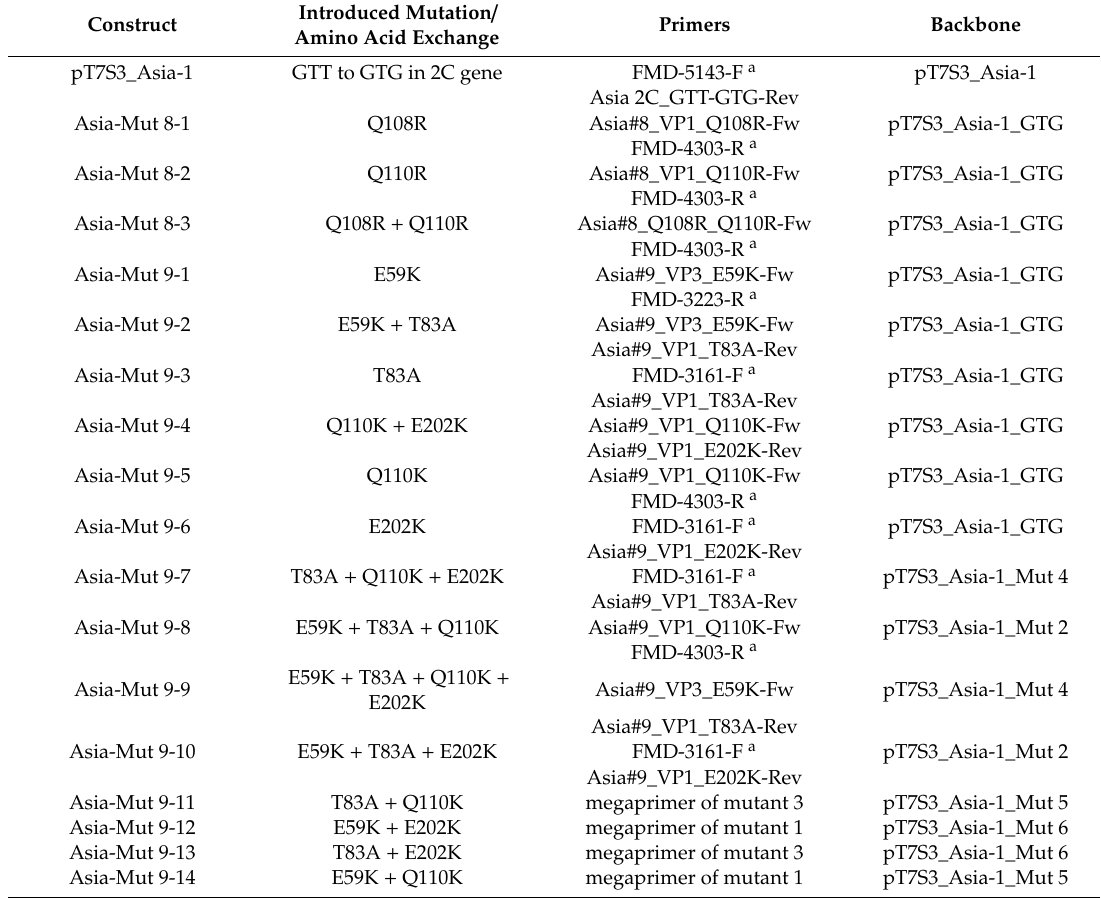
Table 2. Recombinant FMD virus mutants and their corresponding mutations as well as the primer and plasmid backbone used for their